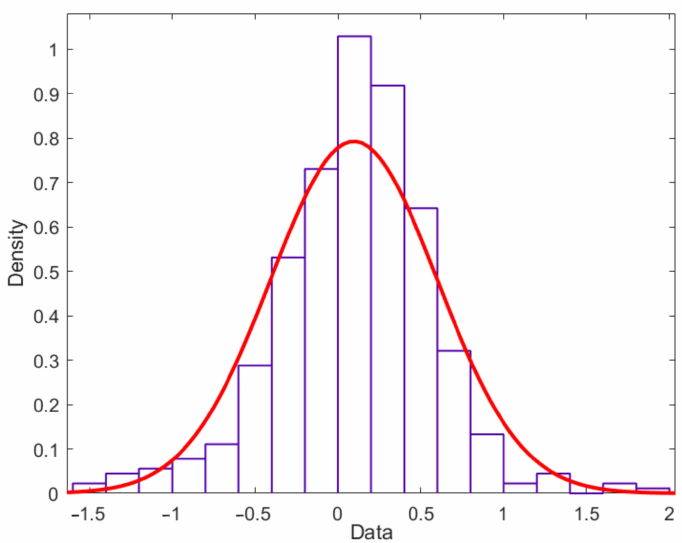
Figure 7. The normal distribution for L1 battery capacity degradation data.